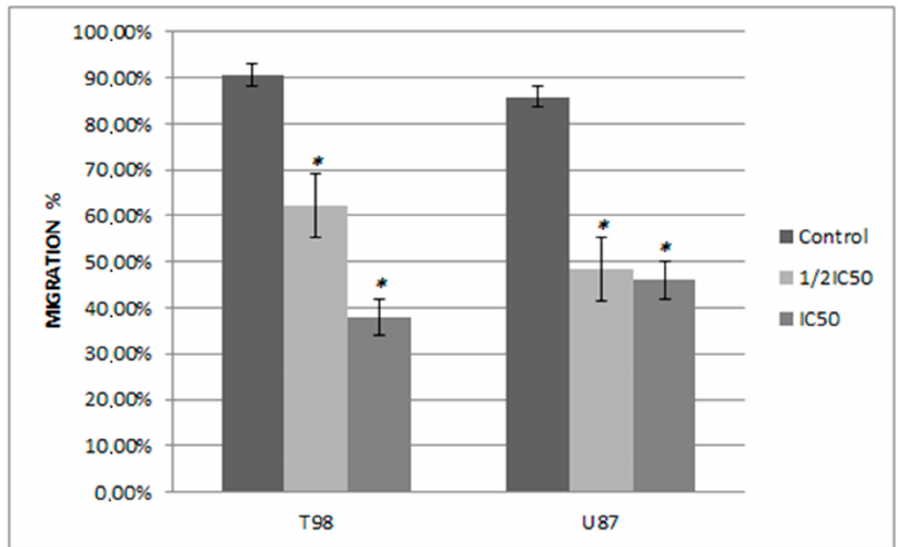
Figure 7. The effect of siderol on the migratory ability of T98 and U87 GBM cell lines at 48 h. Width migration = Width 0h − Width 48h . The experiment was carried out three times. Values expressed as percentages of migration and at 0 h the wound widths were set to 0%. An asterisk is used to indicate differences that are significant ( p < 0.05).